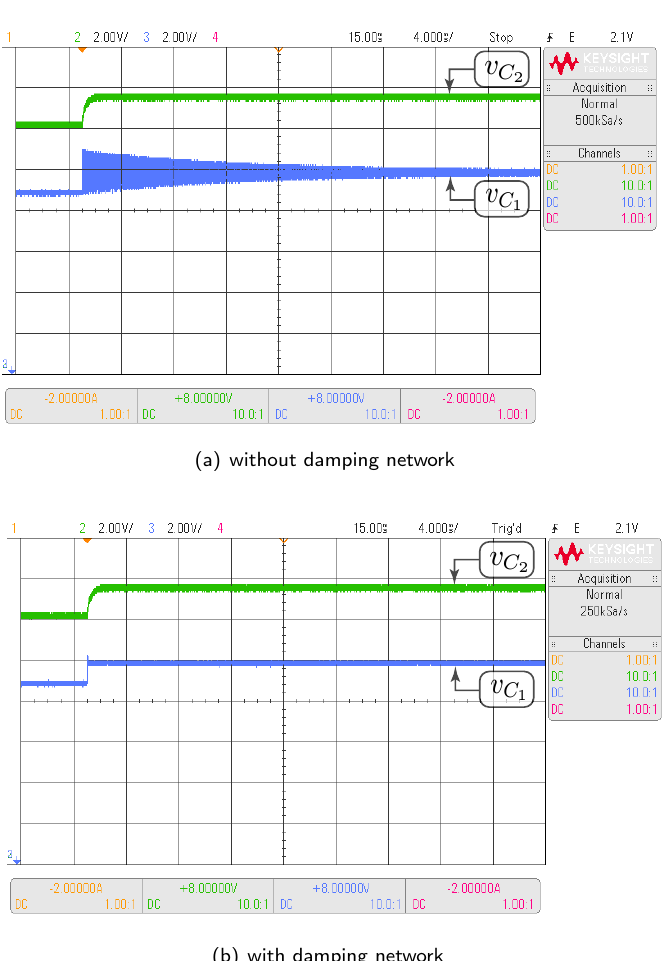
Figure 11. HIL test to validate the proposed model and the simulation of the switched model using PSIM by the SEPIC converter with positive magnetic coupling shown in Figure 7: ( a ) without damping network, ( b ) with damping network. (CH2: v C base of 4